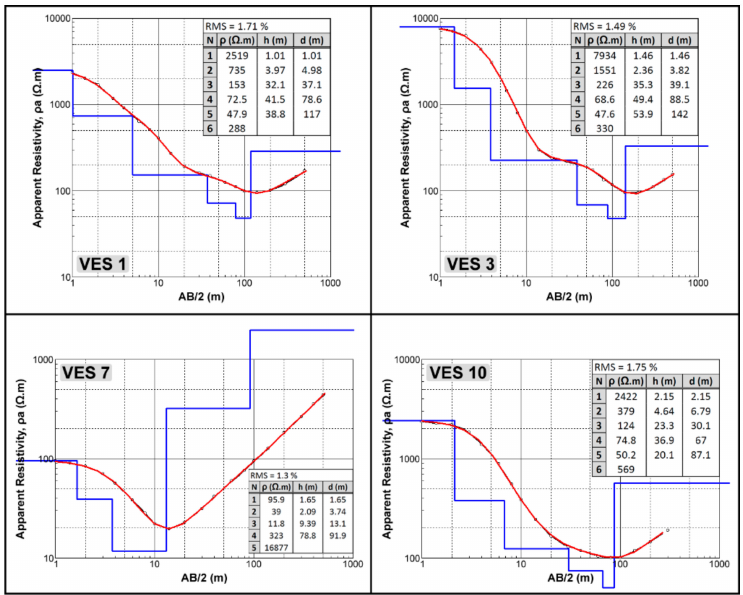
Figure 10. Selective examples of the processed VES field